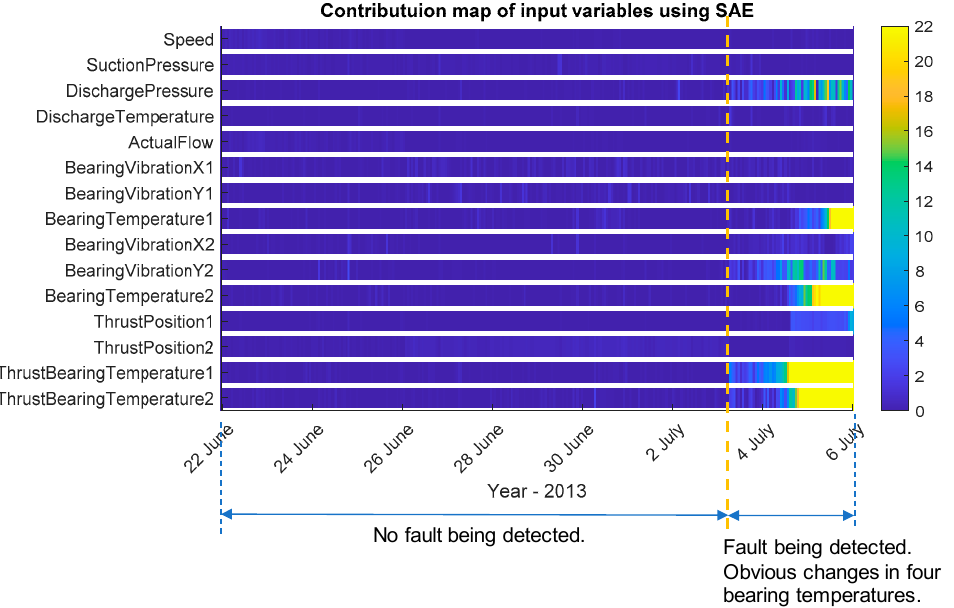
Figure 7. Contribution map by PCA model from 22 June 2013 to 6 July 2013.